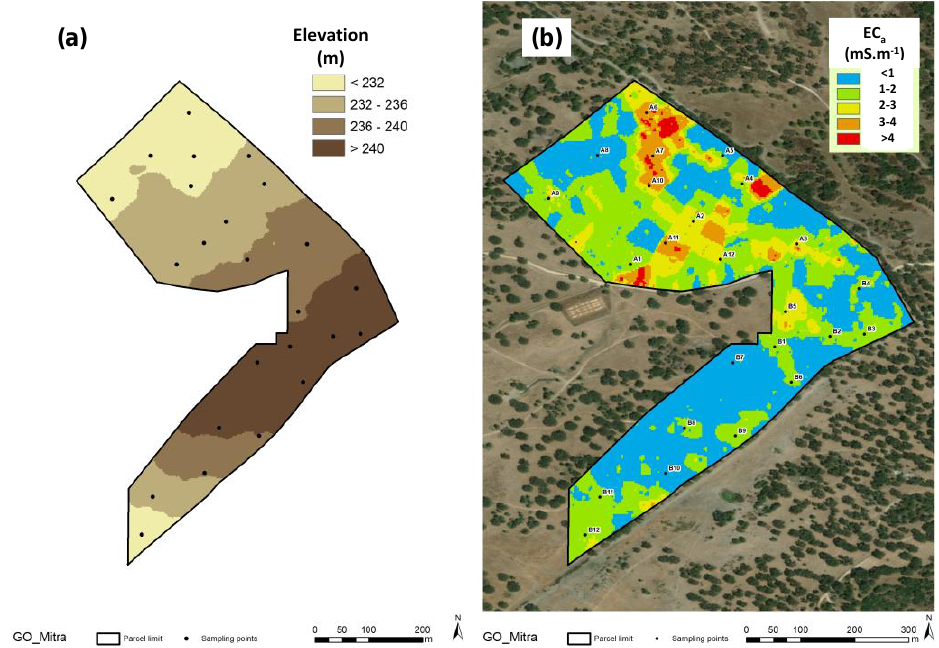
Figure 7. Maps of the experimental field: ( a ) elevation; ( b ) soil apparent electrical conductivity (EC a ).